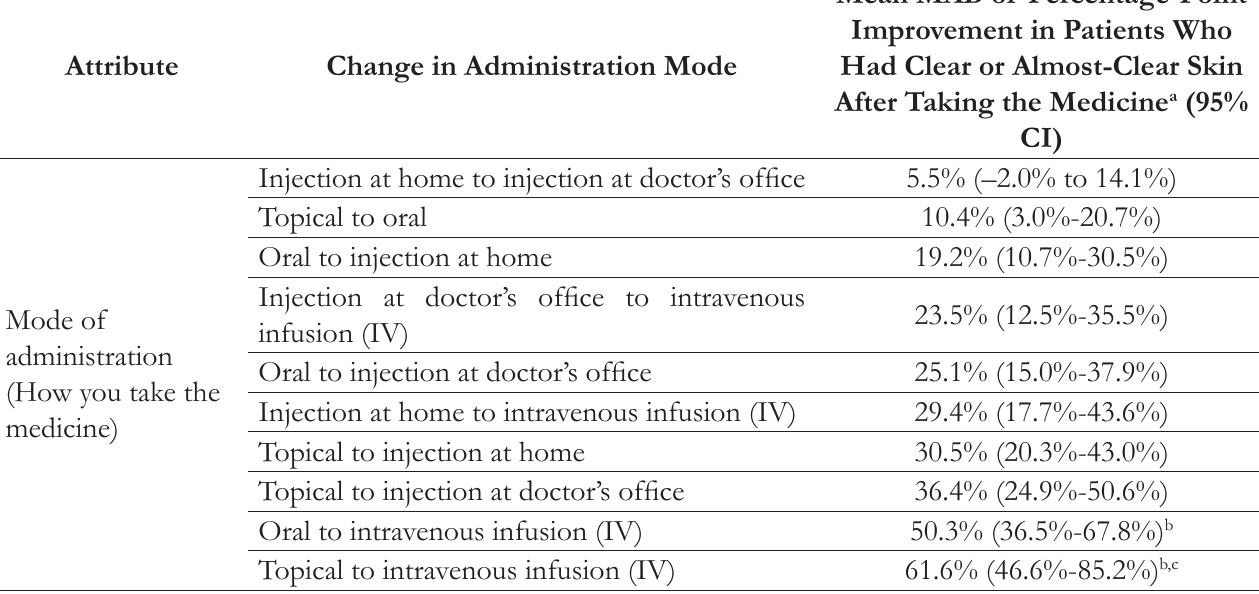
Table 5. Minimum Acceptable Benefit Estimates, Means, and 95% Confidence Intervals (N =